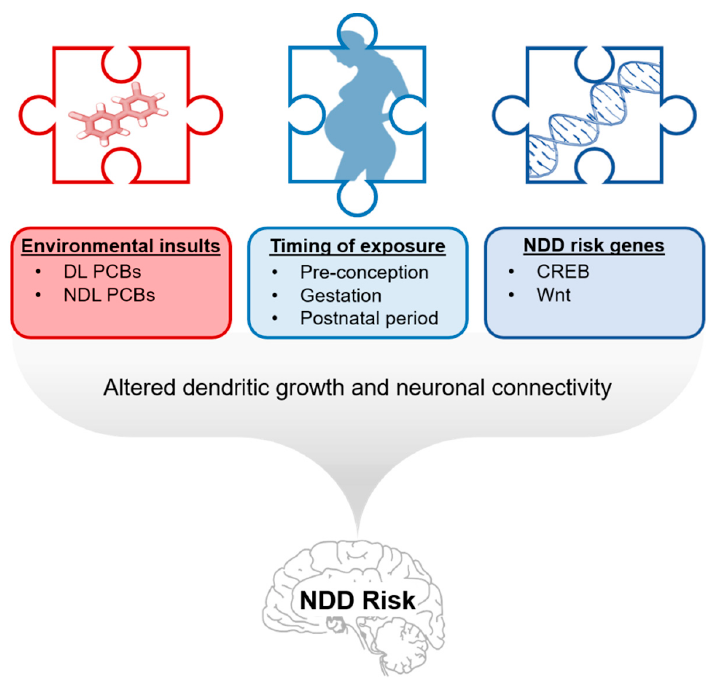
Figure 3. PCBs may interact with heritable mutations in cAMP response element-binding protein (CREB) signaling to influence neurodevelopmental disorder (NDD) risk.